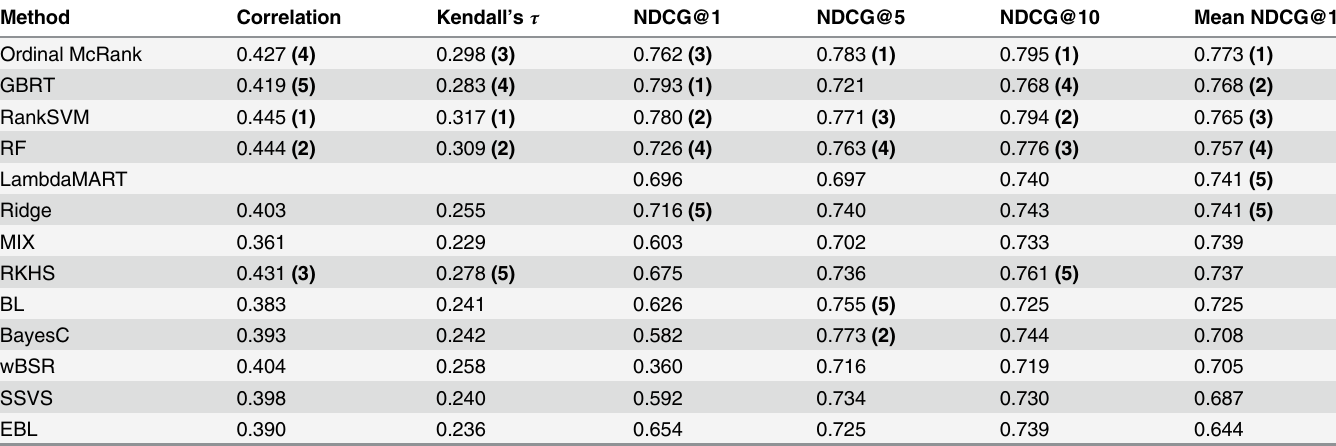
Table 4. Cross-validation results on the Maize dataset.